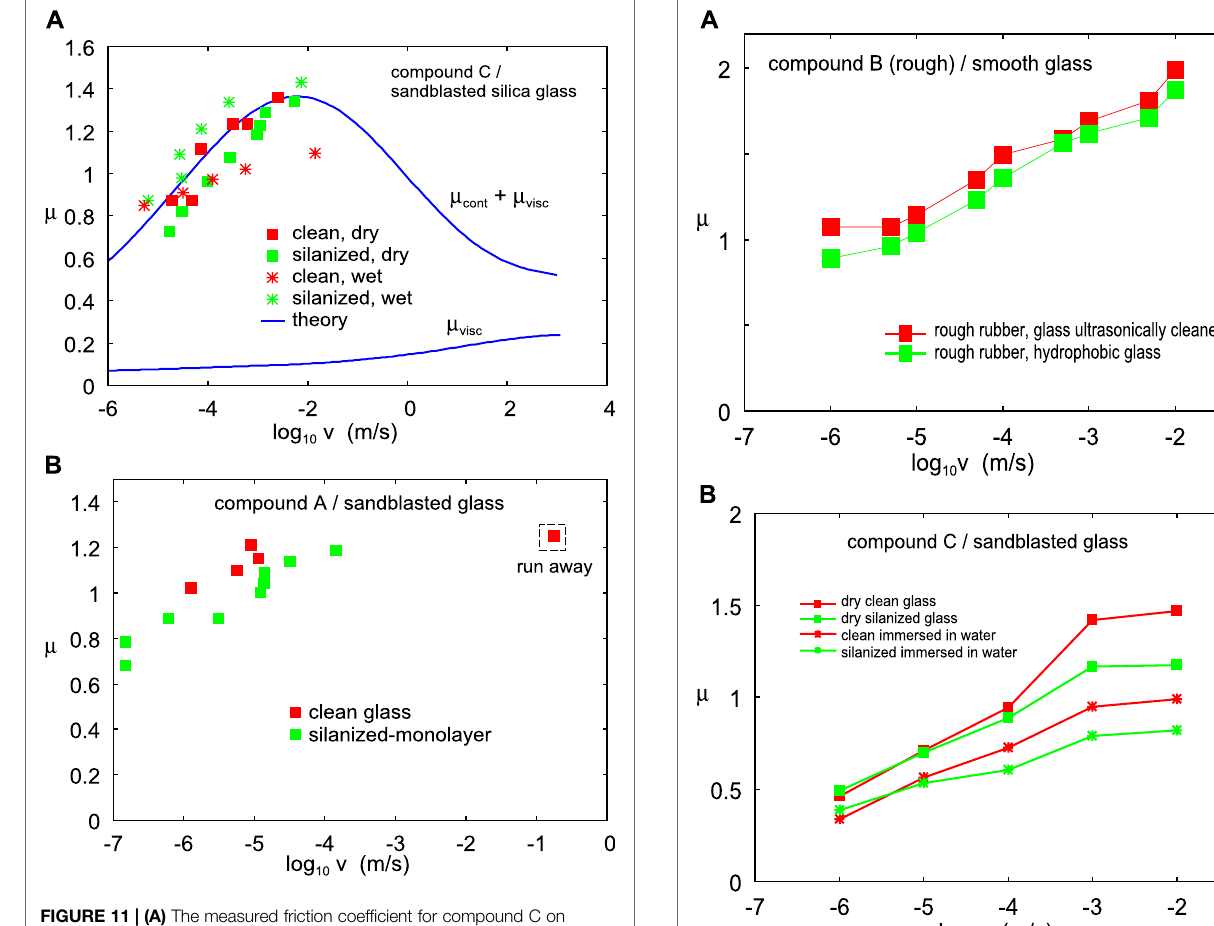
FIGURE 11 | (A) The measured friction coef fi cient for compound C on sandblasted silica glass plates as a function of the logarithm of the sliding speed. The squares are for dry surfaces and the stars in water. The red symbols are the measured friction coef fi cient on a glass surface ultrasonic cleaned in water. The green symbols was obtained on the same type ofglass plate cleaned inthe same way), and then covered byan inert thin fi lm using Rain X. The nominal contact pressure p (cid:1) 0.05 MPa and the temperature T (cid:1) 22 ° C. The blue lines are the theoretically